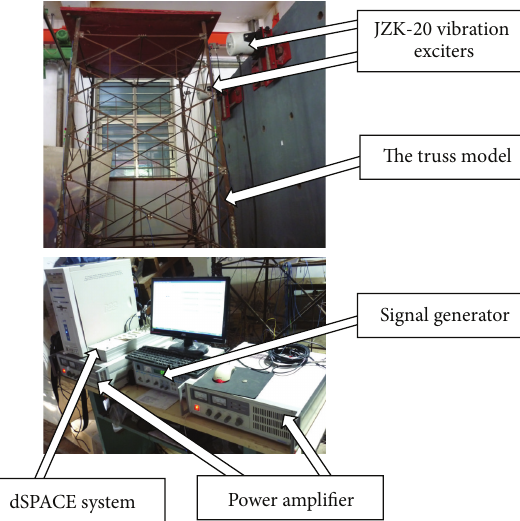
Figure 11: The experimental photo.